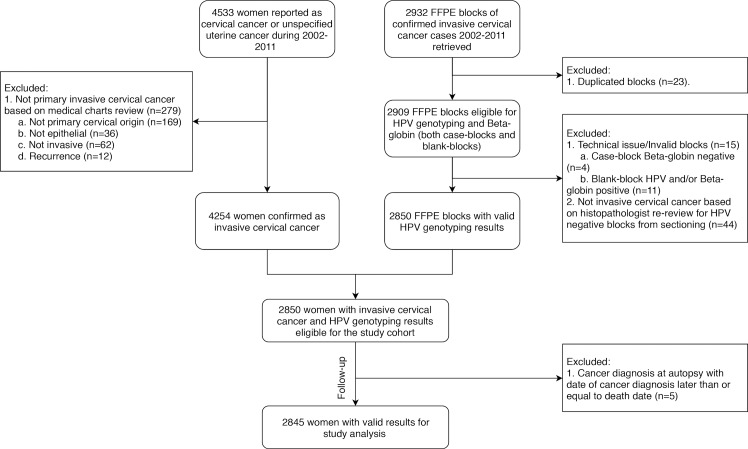
Flow chart of study population.FFPE, formalin-fixed paraffin-embedded; HPV, human papillomavirus.